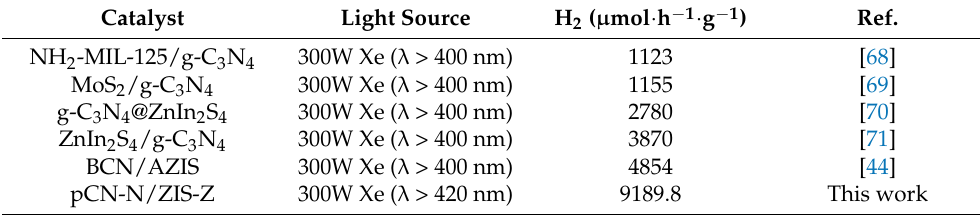
Figure 6. Photocatalytic hydrogen evolution activities of different catalysts ( a ), and the process of producing hydrogen by different catalysts (Insert is an enlarged view of pCN-N) ( b ), wavelength-dependent AQY of H 2 production over pCN-N/ZIS-Z ( c ), comparison of the AQY of pCN-N/ZIS-Z with other similar research results at 420 nm (1 [61], 2 [62], 3 [63], 4 [44], 5 [64], 6 [65], 7 [66], 9 [44], 10 [67]) ( d ). Table 1. The comparison of our work with the results of other similar